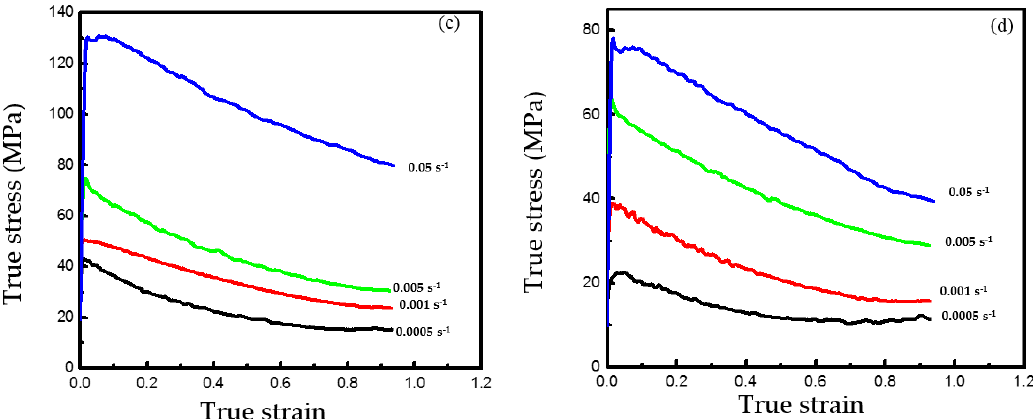
Figure 3. True stress–strain curves for the Ti–6Al–4V alloy under the tested conditions: T = ( a ) 800 °C, ( b ) 830 °C, ( c ) 860 °C, and ( d ) 890 °C.